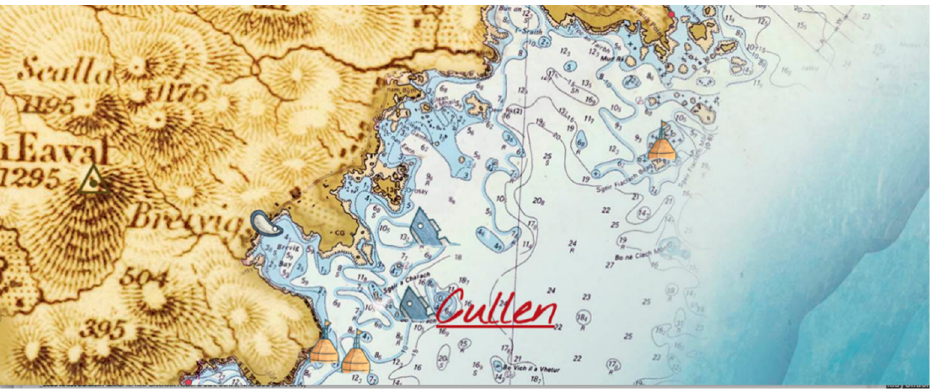
Figure 12. Screenshot of the Cullen shipwreck story in Sea Stories website. Reproduced with permission of the artist. Image used with permission form the artist.